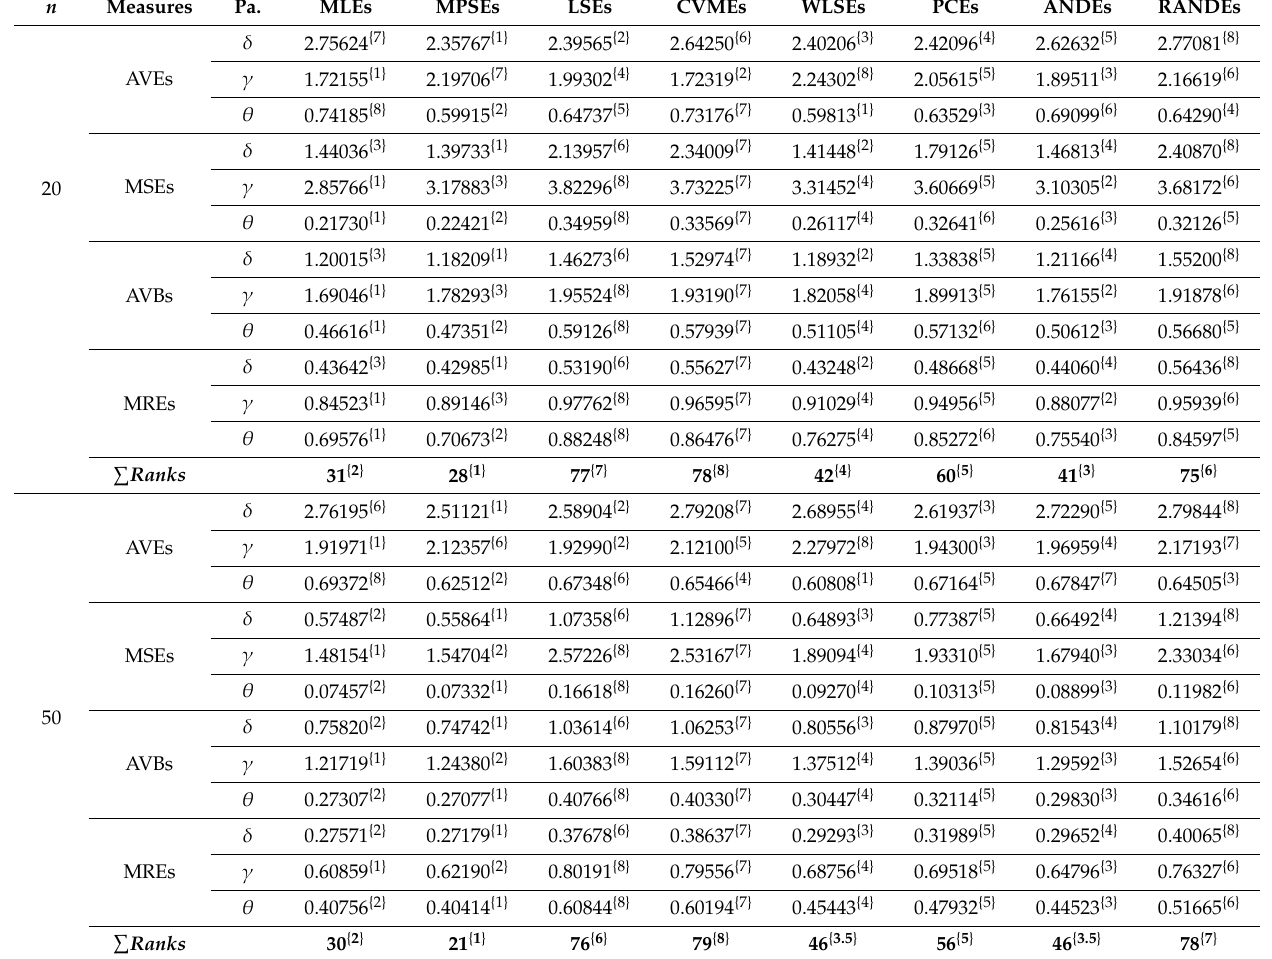
Table A6. Simulation results of several estimation methods for δ = 2.75, γ = 2.00 and θ =